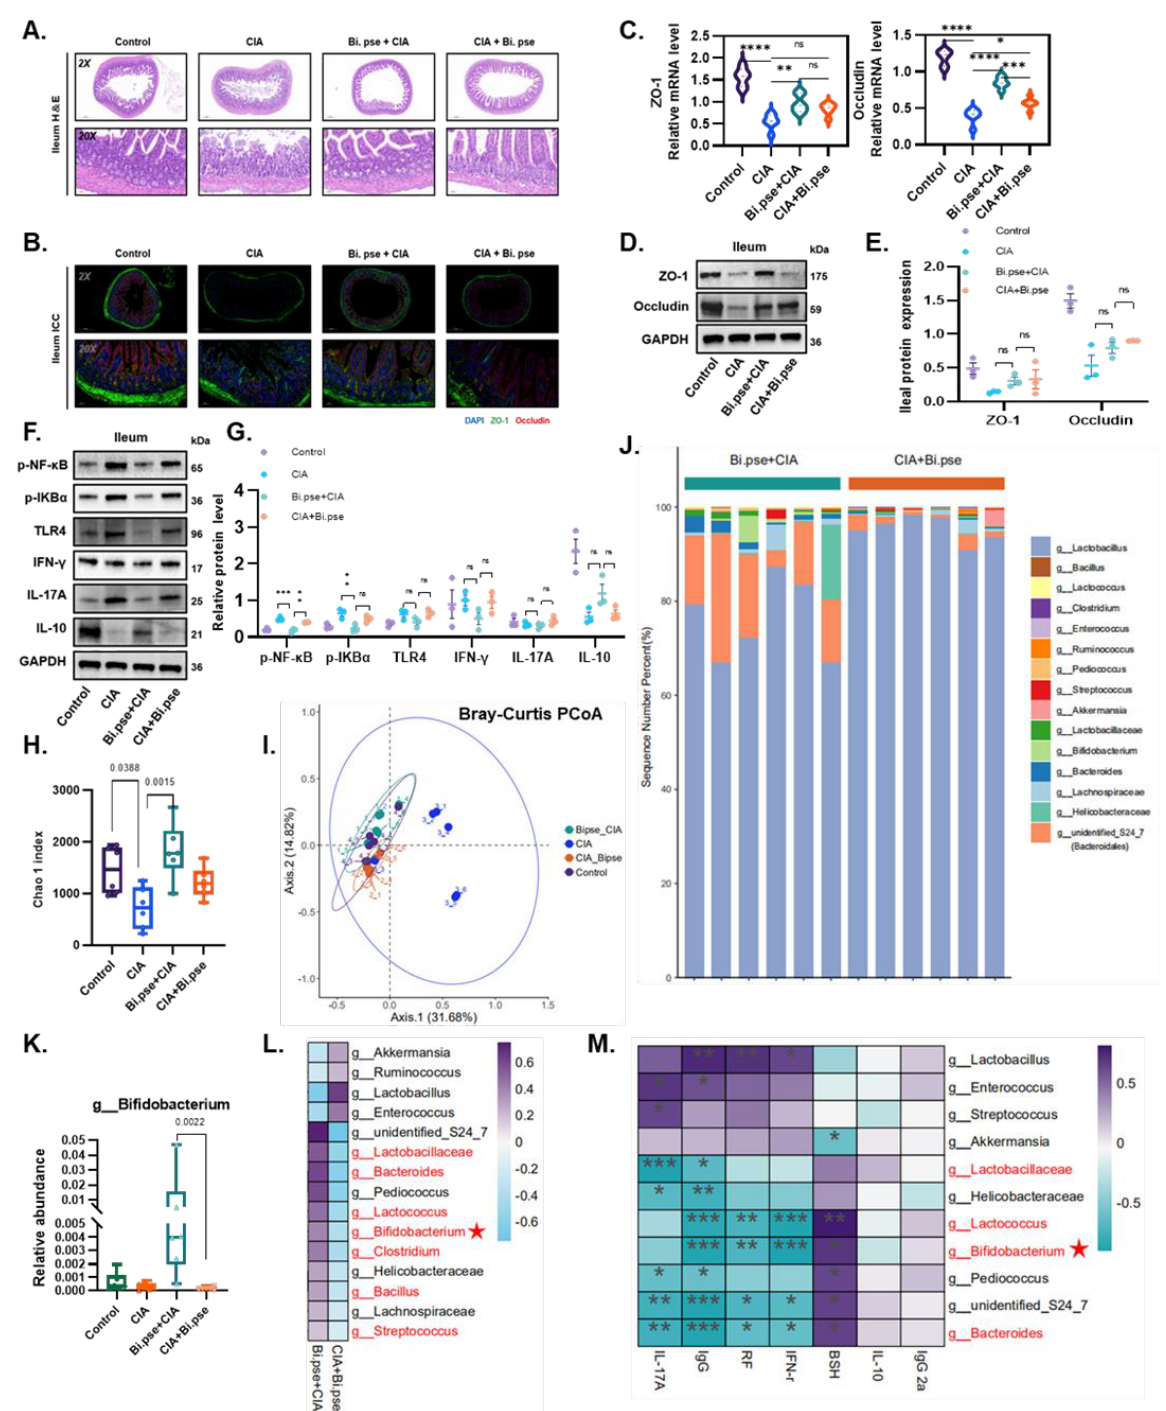
Figure 4. B. pseudocatenulatum protects intestinal barrier function and reshapes the gut microbiota. ( A ) Histopathological changes in ileum tissues with HE staining (scale bars set at 50 and 500 µ m). ( B ) Immunofluorescence-stained sections of ileum using antibodies against ZO-1 (green) and Occludin (red) with DAPI (blue) as the counterstain (scale bars set at 50 and 500 µ m). ( C ) Quantitative RT-PCR and ( D , E ) Western Blot showing expression of ZO-1 and Occludin. ( F ) Representative Western Blot image and ( G ) analysis of the alternative NF- κ B signaling pathway. ( H ) Alpha-diversity analysis (Chao 1 index) of fecal microbiota OTU at various taxonomic ranks. ( I ) PCoA of β -diversity based